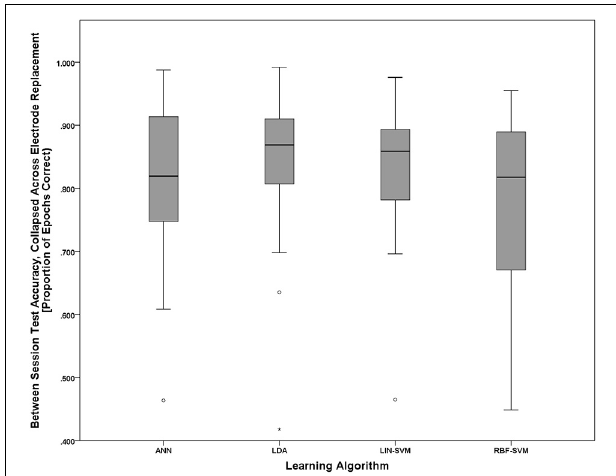
FIGURE 15 | Boxplots showing between-session classifier accuracy, collapsed across group, data representative of the post-hoc pairwise comparison testing given the significant main effect of learning approach shown in Figure 14. Despite the significant main effect shown in Figure 14 , all post-hoc pairwise comparison tests were non-significant (using the Bonferroni correction for multiple comparisons), although the two comparisons that approached significance were ANN vs. RBF-SVM and LDA vs. RBF-SVM. The boxplots shown represent the median (line inside the box), first and third quartiles (bottom and top of the box, or the lower and upper hinges, respectively), and minimum and maximum values (lower and upper whiskers, respectively, or inner fences). Outliers exceeding 1.5 times the box height are shown as individual sample points (circles). Extreme outliers, or those samples exceeding 3 times the box height, are indicated by asterisks.